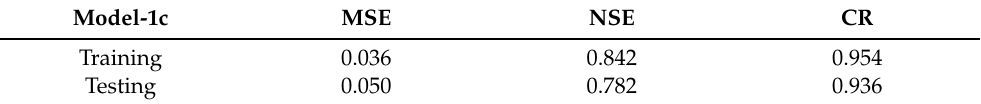
Table A5. Time-averaged model evaluation scores: The mean squared errors (MSEs), Nash–Sutcliffe model efficiency coefficients (NSEs), and the correct classification rates (CRs) for